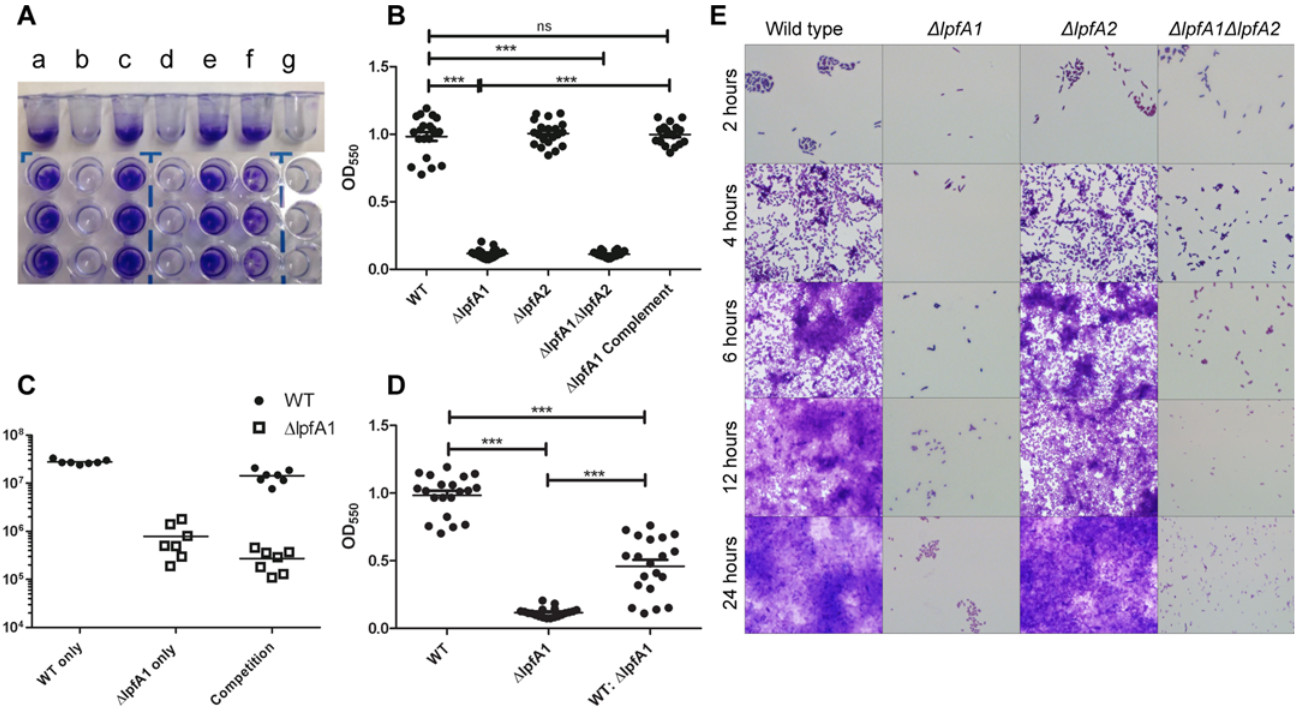
Fig 4. Δ lpfA1 and Δ lpfA2 ’ s effect on stable biofilm formation. Microtiter plates were washed and stained with crystal violet and biofilms visualized in (A) and quantified in (B) of E . coli O104:H4 (a), Δ lpfA1 (b), Δ lpfA2 (c), Δ lpfA1 Δ lpfA2 (d), Δ lpfA1 complemented (e), O104:H4 wt and Δ lpfA1 mix (f) or MEM media alone (g) after 24 h of static incubation at 37°C. Competition assays were done with O104:H4 2011 c3494 wild type and Δ lpfA1 mutant, and results are expressed as absorbance at 550 nm (C) and CFUs recovered (D). Formation of biofilm by all E . coli O104:H4 wild type and mutant strains were visualized by growing on glass cover slips, stained and imaged at 2, 4, 6, 12, and 24 h post-infection (E). All experiments were done with a 1:100 dilution of overnight cultures diluted to and OD 600 of 1.0. Error bars indicated SEM of 3 independent experiments each performed with triplicate